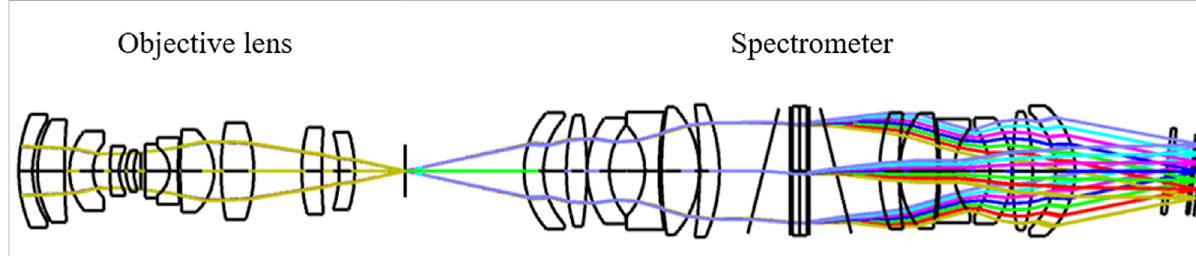
FIGURE 1 Optical structure of the whole underwater hyperspectral imaging system.